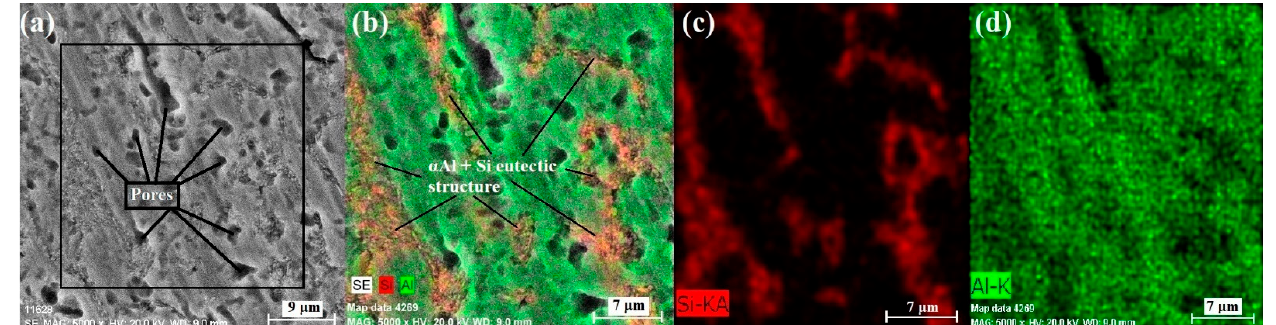
Figure 9. Sample “M2” taken from the specimen build at a welding speed of 13.3 mm/s: ( a ) SEM micrograph of the studied zone; ( b ) EDX mapping; ( c ) silicon content detected; ( d ) aluminum content detected.